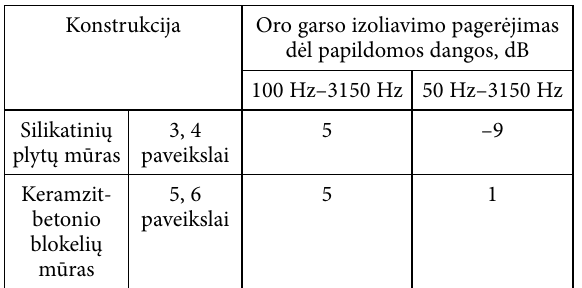
Fig. 7. Wall construction from expanded-clay concrete blocks with an additional cover installed on the metal frame